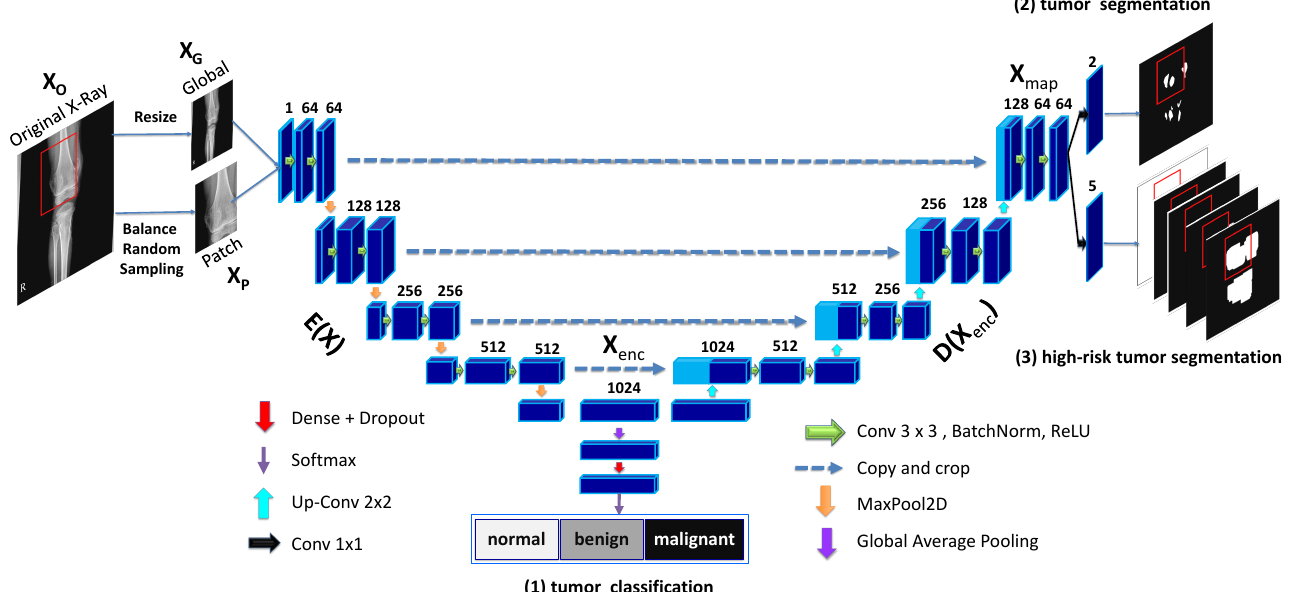
Figure A3. Multi-level Seg-Unet model with global and patch-based